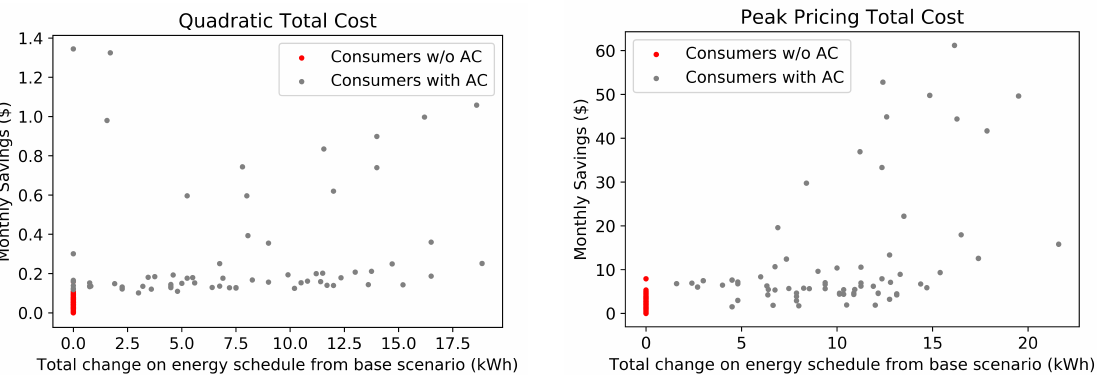
Figure 9. Consumers’ monthly savings according to their “used